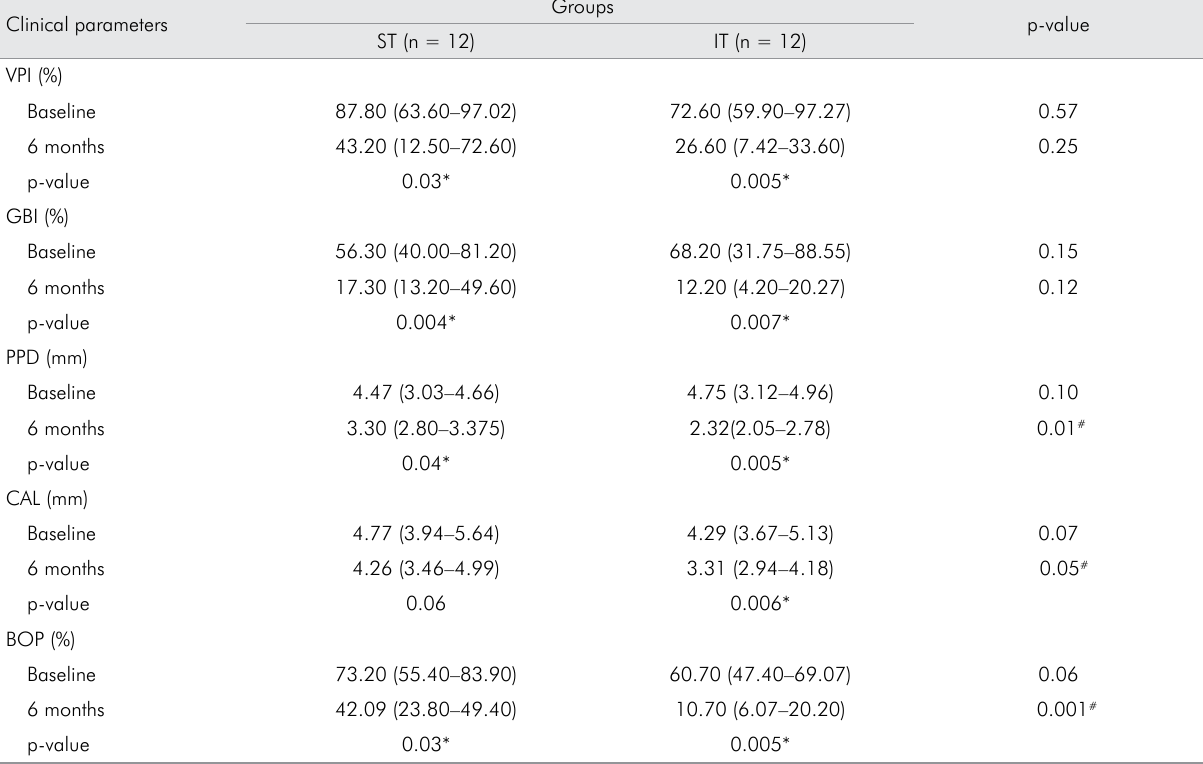
Table 1. Medians values (75 th /25 th percentiles) for clinical periodontal parameters at baseline and 6 months post-therapy for the supragingival therapy (ST; n = 12) and the intensive periodontal therapy (IT; n = 12) groups.